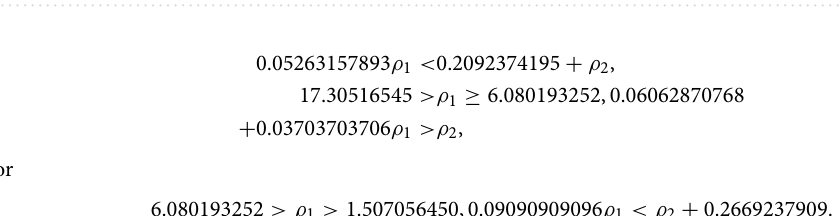
Figure 18. Bifurcation diagrams for the controlled system (28) with ρ 1 ( 0.2672612419, 9.621404709 ) and ρ 2 p 1 ( x ∗ , y ∗ ) =